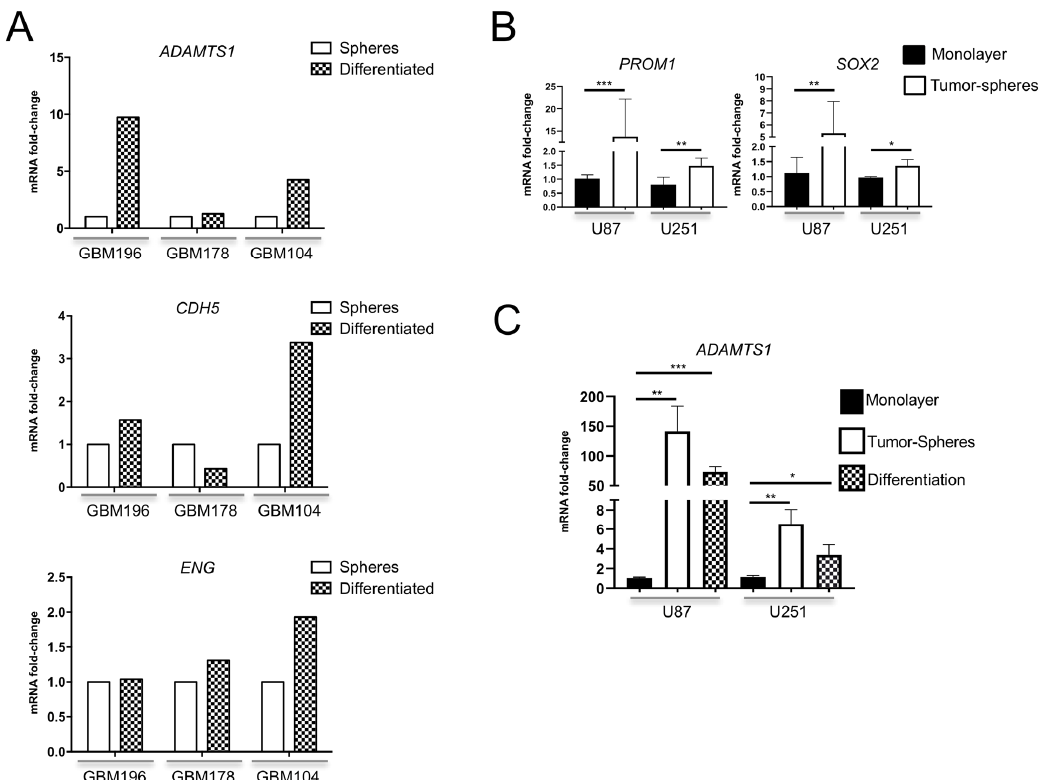
Figure 2. Evaluation of ADAMTS1 gene expression and plasticity in GICs and GBM cell lines. ( A ) Graphs representing mRNA fold change expression of ADAMTS1 , CDH5 and ENG in independent GICs as spheres and undergoing differentiation (standard deviation is not included in these graphs as they represent individual tumor samples); ( B ) Graph representing mRNA fold change expression of stemness markers PROM1 and SOX2 in monolayer cultures and tumor-spheres derived from U87-MG and U251-MG cells ( n ≥ 3 samples for all cell lines); ( C ) Graphs representing mRNA fold change expression of ADAMTS1 in monolayer cultures, tumor-spheres, and differentiation status, derived from U87-MG, and U251-MG cells ( n ≥ 3 samples for all cell lines). ***, p < 0.001; **, p < 0.01; and *, p < 0.05.